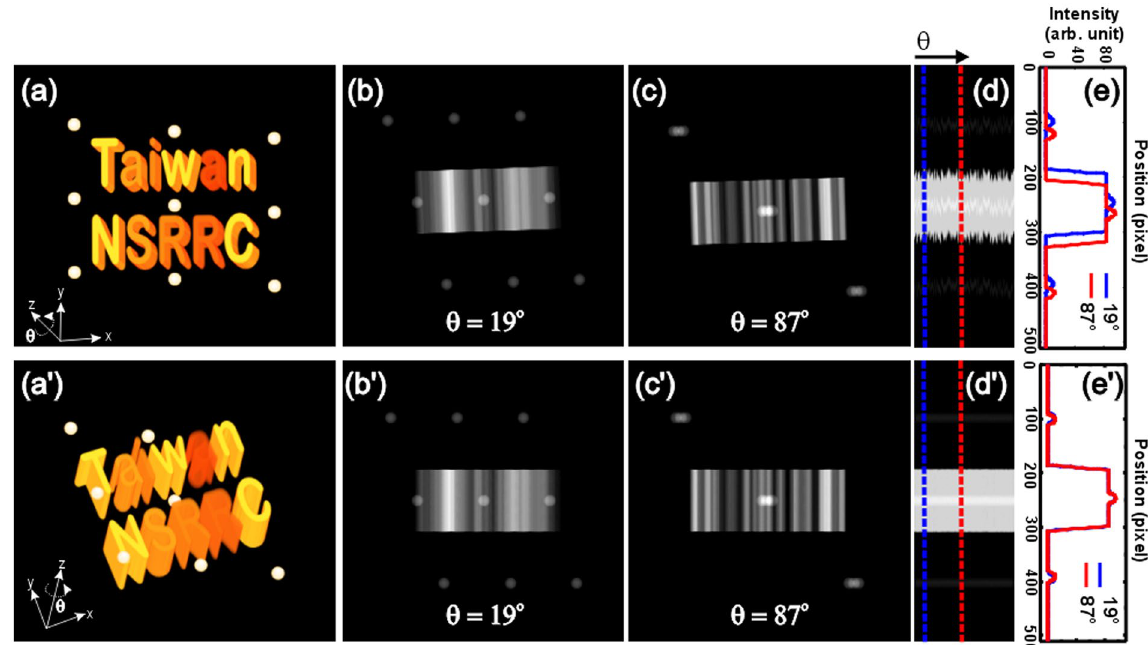
Figure 3. Demonstration of the Faproma’s first correction process using a computer-generated 3D phantom. ( a ) and (a’) show the artificial 3D object. ( b ) and ( c ) are simulated raw projections obtained from 19° and 87° azimuth angles, respectively, which were vertically shifted and rotated by computer in a random method. ( d ) The HSs obtained from 0° to 180° azimuth angles from the stimulated raw projections. The positions of the blue and red lines are the HSs, which were obtained from 19° and 87° azimuth angles, respectively. ( e ) The blue and red line profiles of the raw HSs are captured from projections, which were obtained from 19° and 87° azimuth angles, respectively. (b’) and (c’) are corrected projections obtained from 19° and 87° azimuth angles, respectively. (d’) Corrected HSs. The positions of the blue and red lines are the corrected HSs of projections, which were obtained from 19° and 87° azimuth angles, respectively. (e’) The blue and red line profiles are HSs, which were obtained from 19° and 87° azimuth angles, respectively, and were corrected by the Faproma’s first correction process. We can see these two HSs are aligned both in intensity profile and y